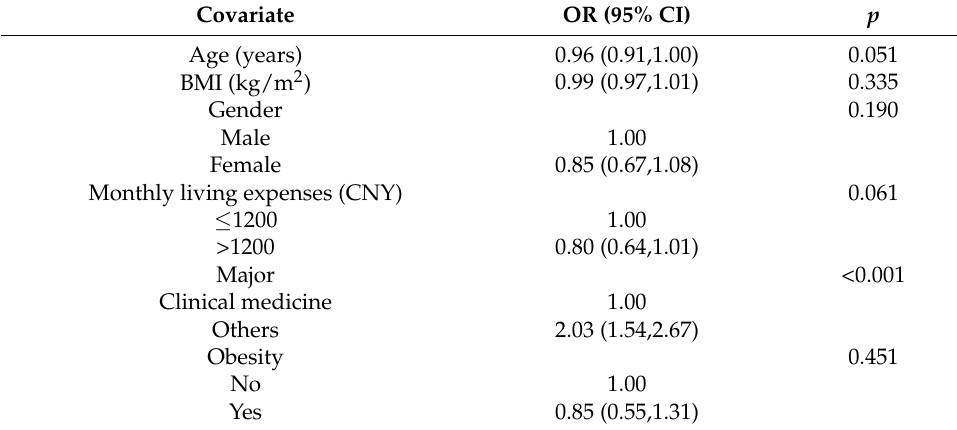
Table 2. The association between characteristics of participants and irritable bowel syndrome by univariate analysis ( n =